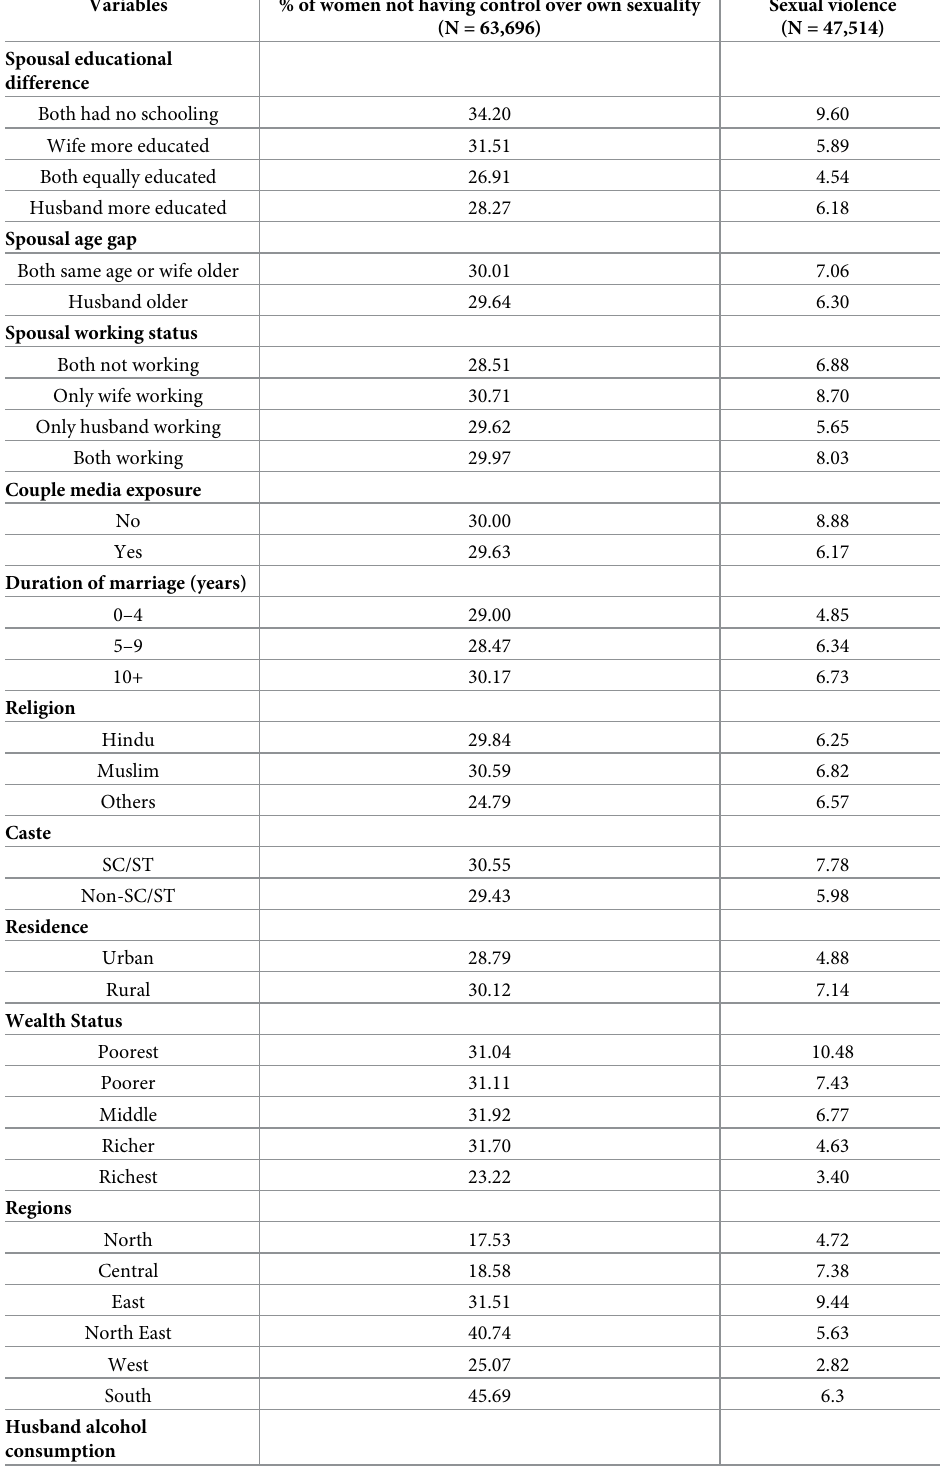
Table 2. Percentage of women not having control over own sexuality and experienced sexual violence by back- ground characteristics in